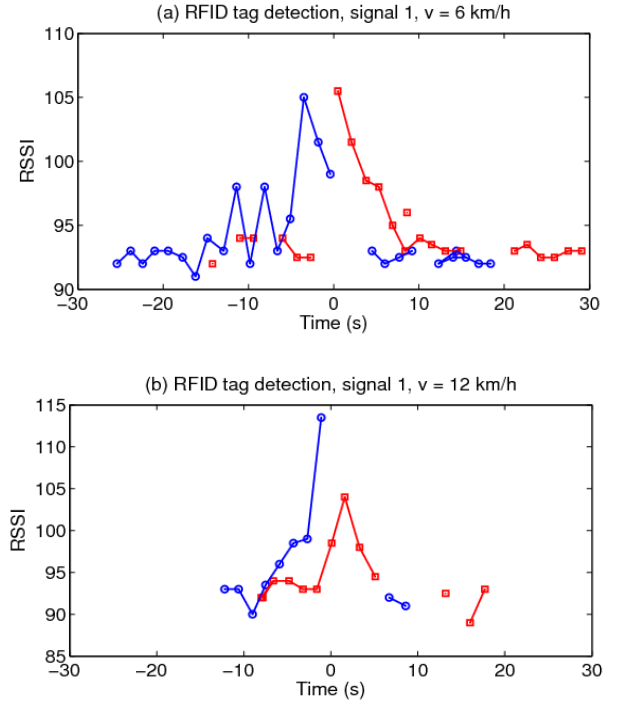
Figure 7. Readings of front (blue) and back (red) tags of the first traffic signal detected by the car at three different speeds (6, 12, and 24